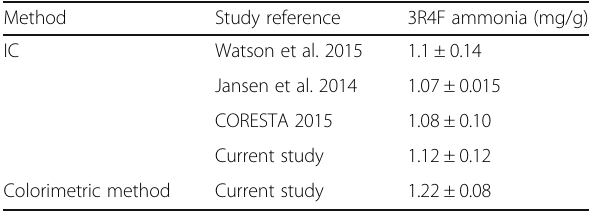
Table 1 Comparison of ammonia in 3R4F tobacco filler by